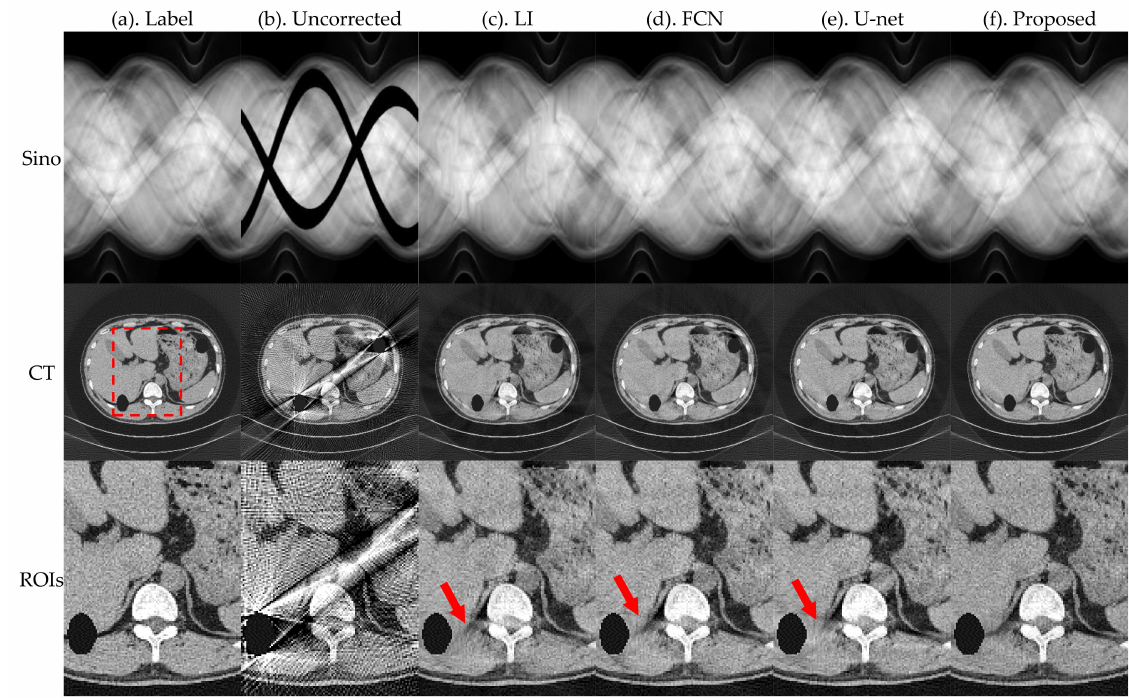
Figure 5. Simulation results of the pleural, where the first row is the sinogram, and the second row is the FBP-reconstructed results. The display window of sinogram is (0, 1). The display window of CT is ( − 0.1,